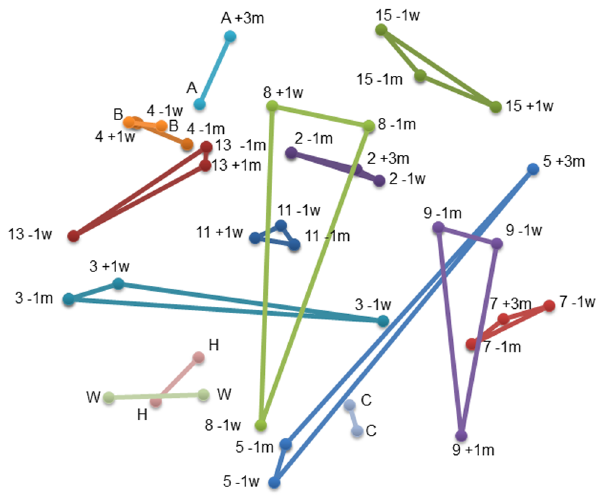
Figure 4. NMDS plot of the microbial 16S rRNA communities of subjects’ samples using a distance matrix calculated with the Yue and Clayton theta similarity coefficient. The plot of the two NMDS axes was generated using a distance matrix calculated at the 3% level, with the Yue and Clayton theta similarity coefficient within Mothur for all samples. The distance between two points is directly proportional to the Yue and Clayton theta similarity value for two samples such that sites positioned close together share a similar abundance in OTUs than samples further apart. NMDS stress=0.52. Refer to Figure 1 legend for sample labelling.